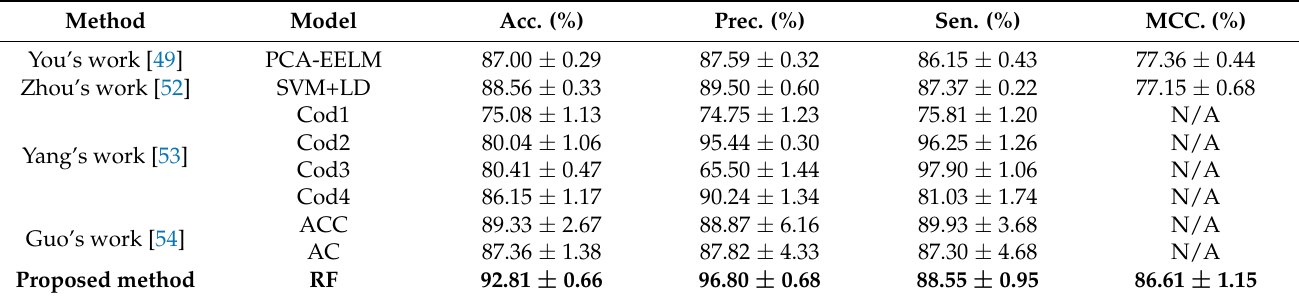
Table 9. Comparison results of different methods on Yeast